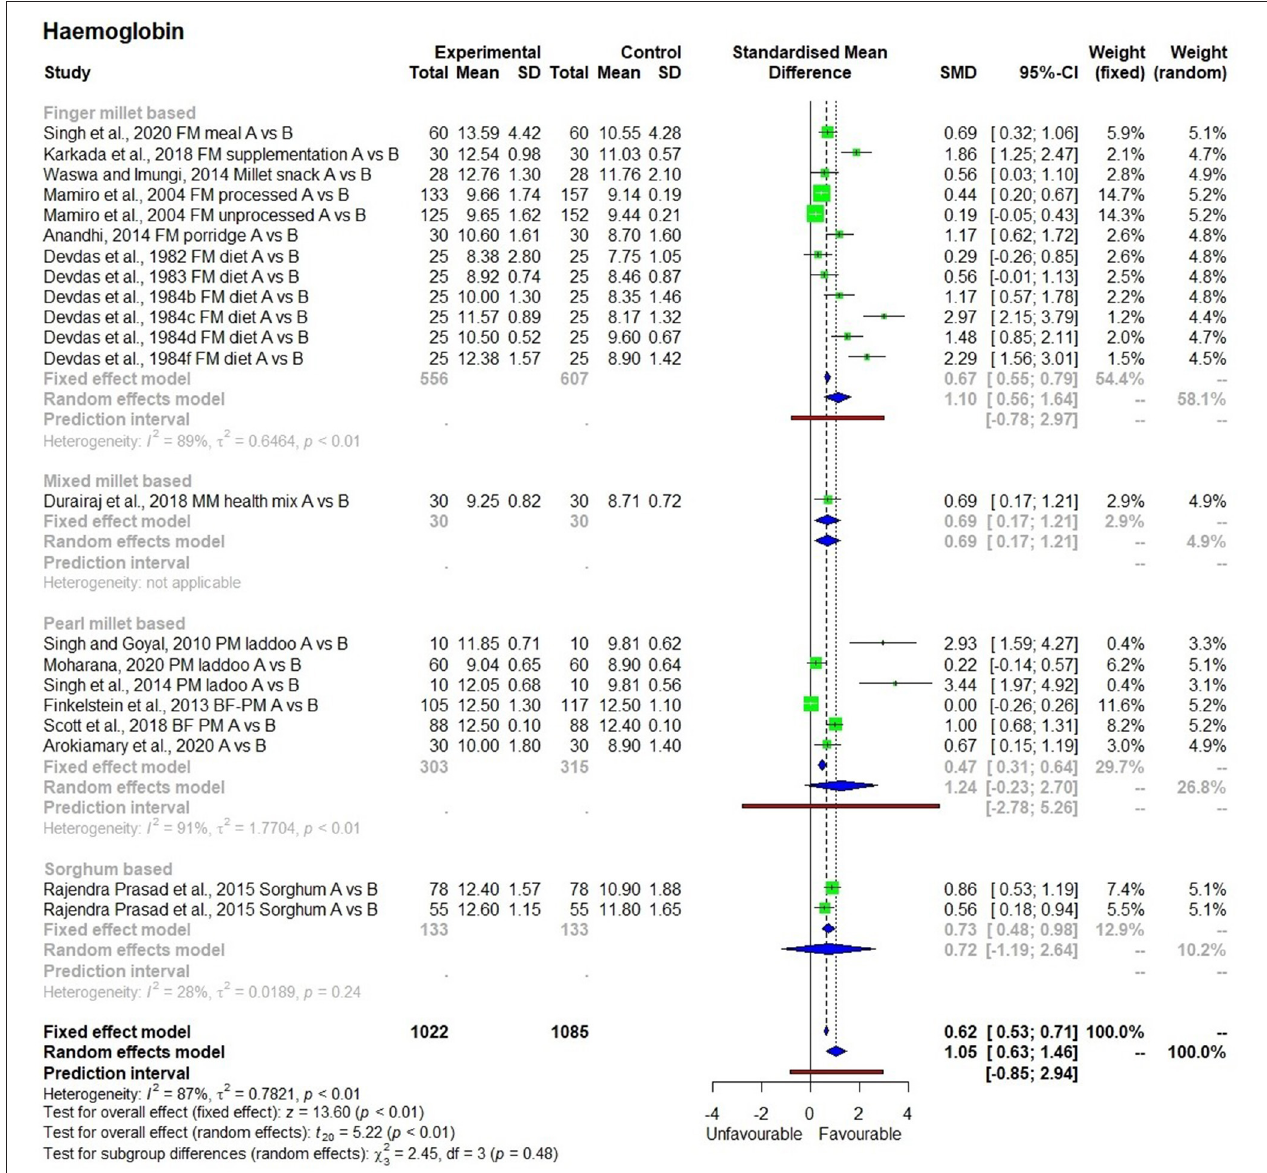
FIGURE 8 | Effect of consuming different types of millets on Hemoglobin